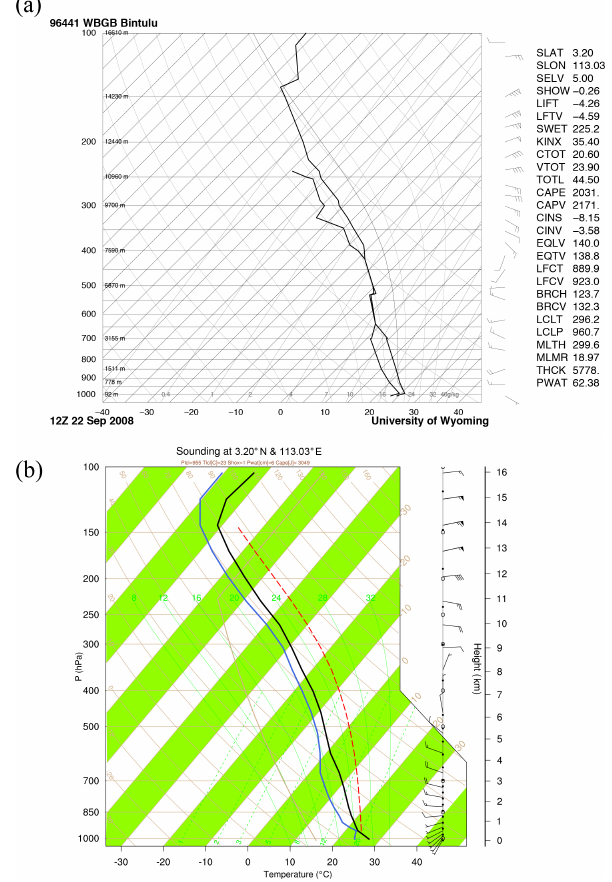
Figure 5. (a) Sounding profile observed at Bintulu Airport, Malaysia (3.20 ◦ N, 113.03 ◦ E) at 12:00UTC on 22 September 2008. (b) Modeled sounding profile in FFBB at the same location and time as (a)